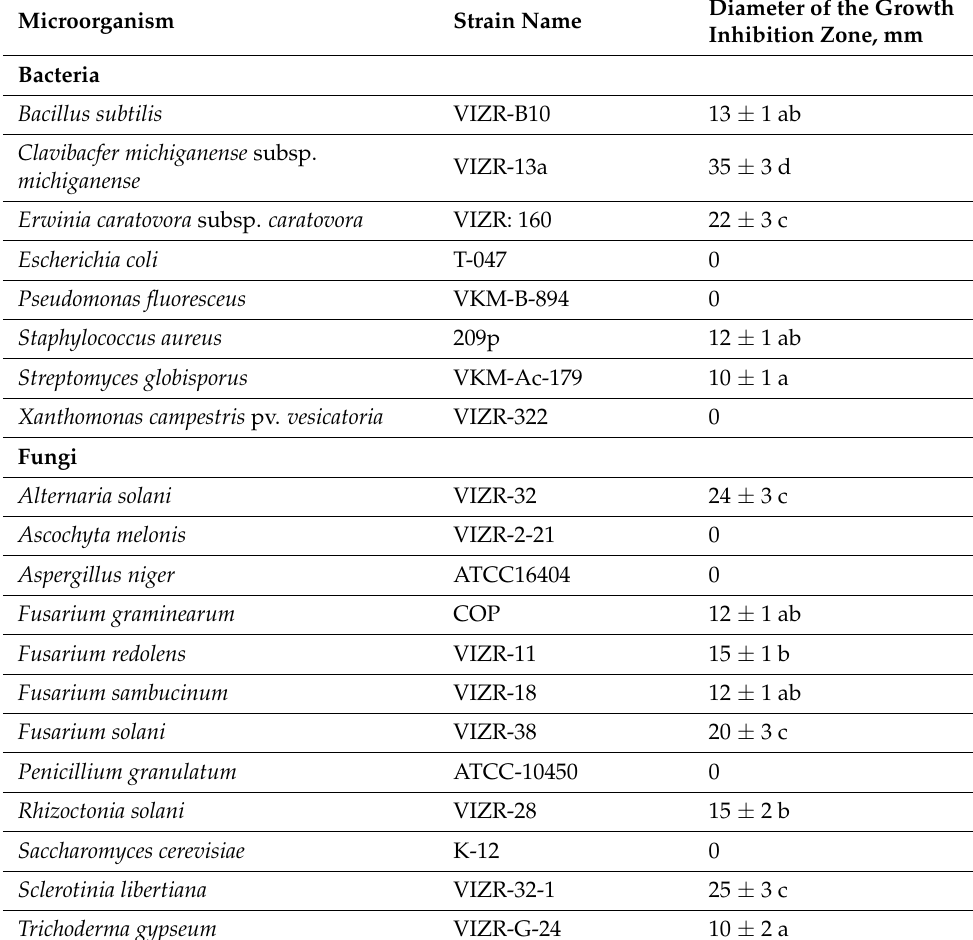
Diameter of the Growth Inhibition Zone, mm